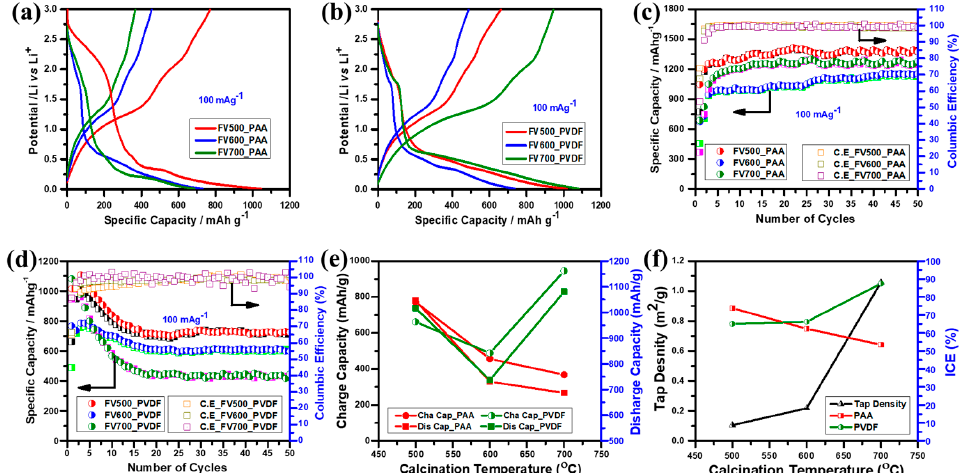
Figure 6. ( a , b ) Galvanostatic discharge/charge profiles and ( c , d ) cyclic performance of FV500, FV600, and FV700 at 35-weight % PAA and 5-weight % PVDF binders at current densities of 100 mAg − 1 under the voltage range of 0.005 V-3.0 V, respectively (Color illustration: Black, Green, and Magenta colors represented the charge capacities; Red, Blue, and Olive colors represented the discharge capacities, respectively.). Correlation of ( e ) charge/discharge capacities and ( f ) tap density and initial coulombic efficiency of FV500, FV600, and FV700 at 35-weight % PAA and 5-weight % PVDF binders with different calcination temperatures,